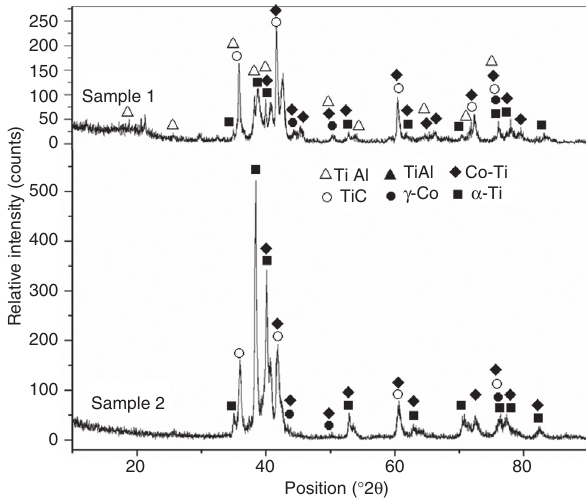
Figure 2 XRD diagrams of the composite coatings in samples 1 and 2.